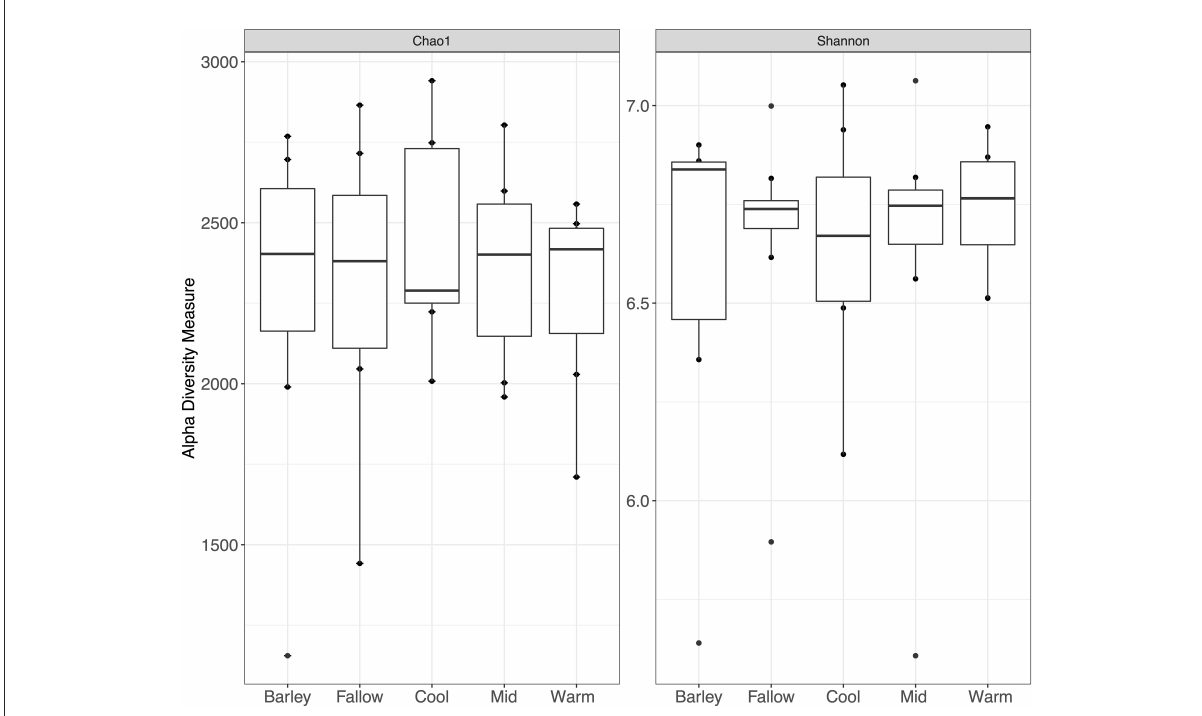
FIGURE2 Chao1 and Shannon diversity indices for cover crop treatments. Mean values shown are averages across all termination methods since no significant differences were observed between termination methods. Differences in alpha diversity were also not significant between cover crop treatments.